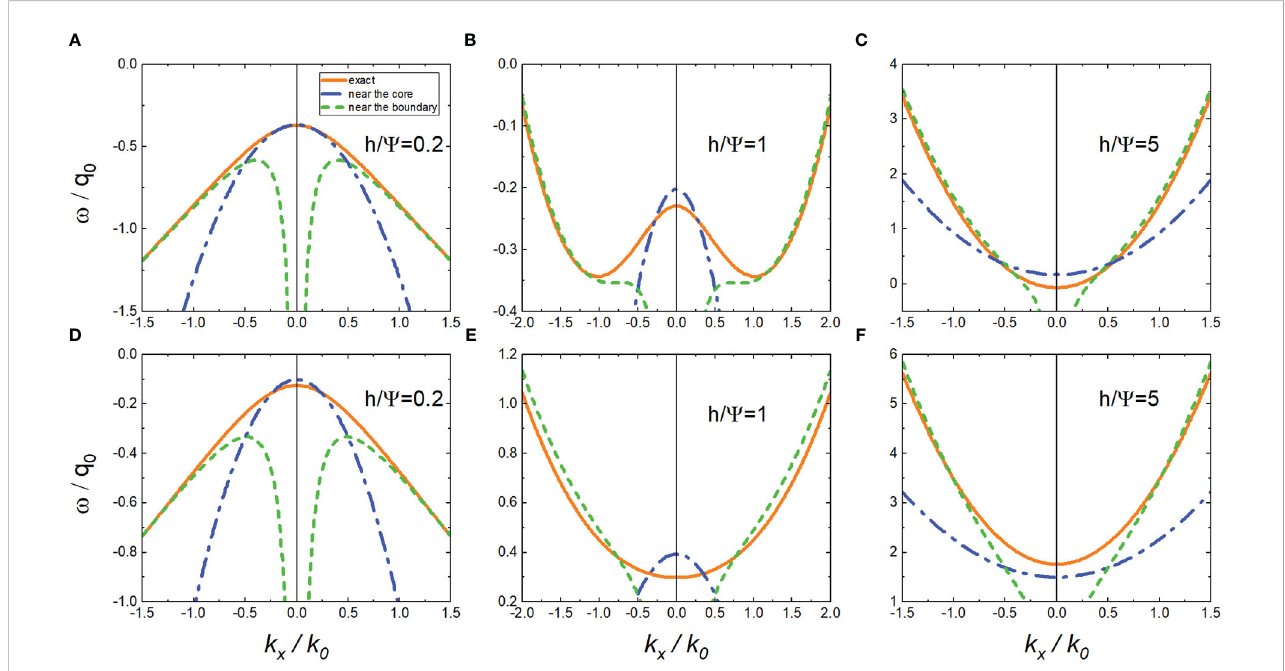
FIGURE 5 Dispersion relation of the lowest eigenvalues of M C ( w ′ , x , y ′ ) (A – C) and M S ( w ′ , x , y ′ ) (D – F) with h = Y =